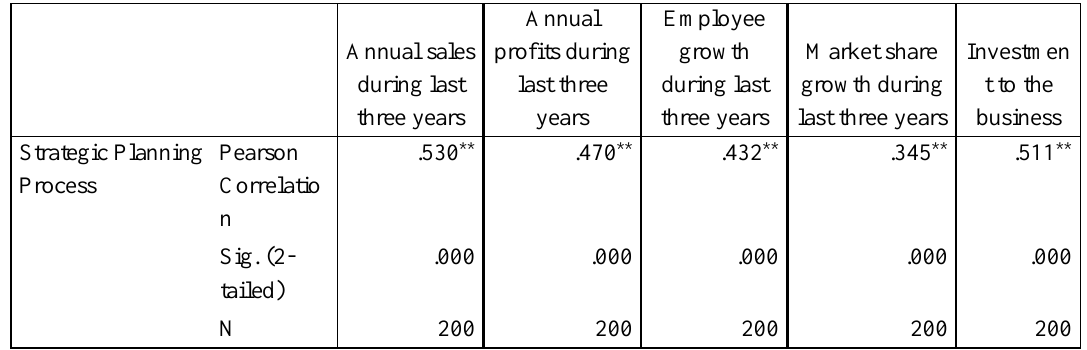
**. Correlation is significant at the 0.01 level (2-tailed).